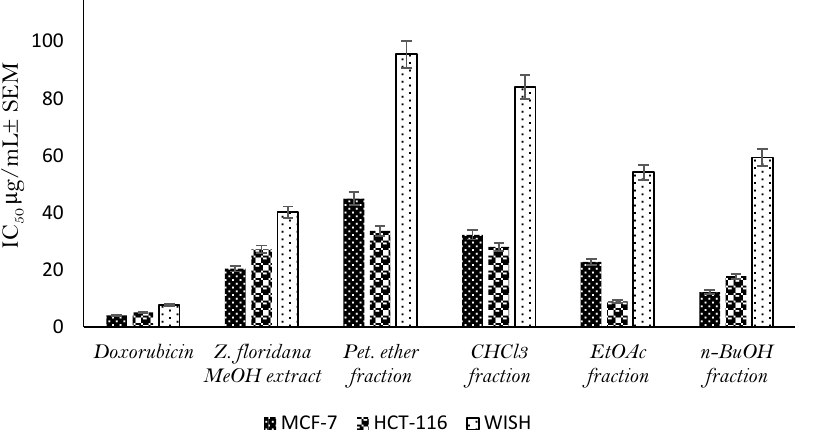
Figure 2. Cytotoxic effect (IC 50 ± SEM) of Z. floridana methanol extract and its different fractions against different cell lines.